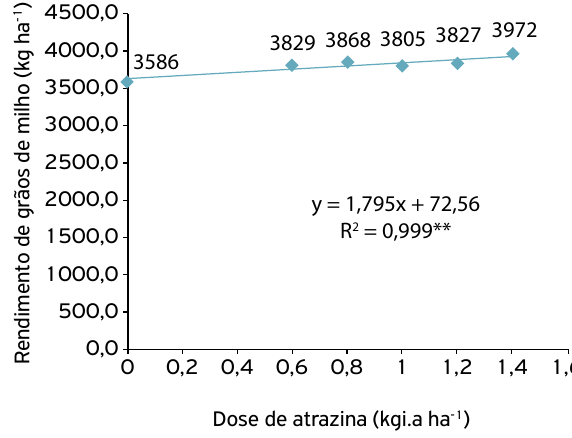
Figura 2. Número de plantas de Brachiaria ruziziensis aos 15